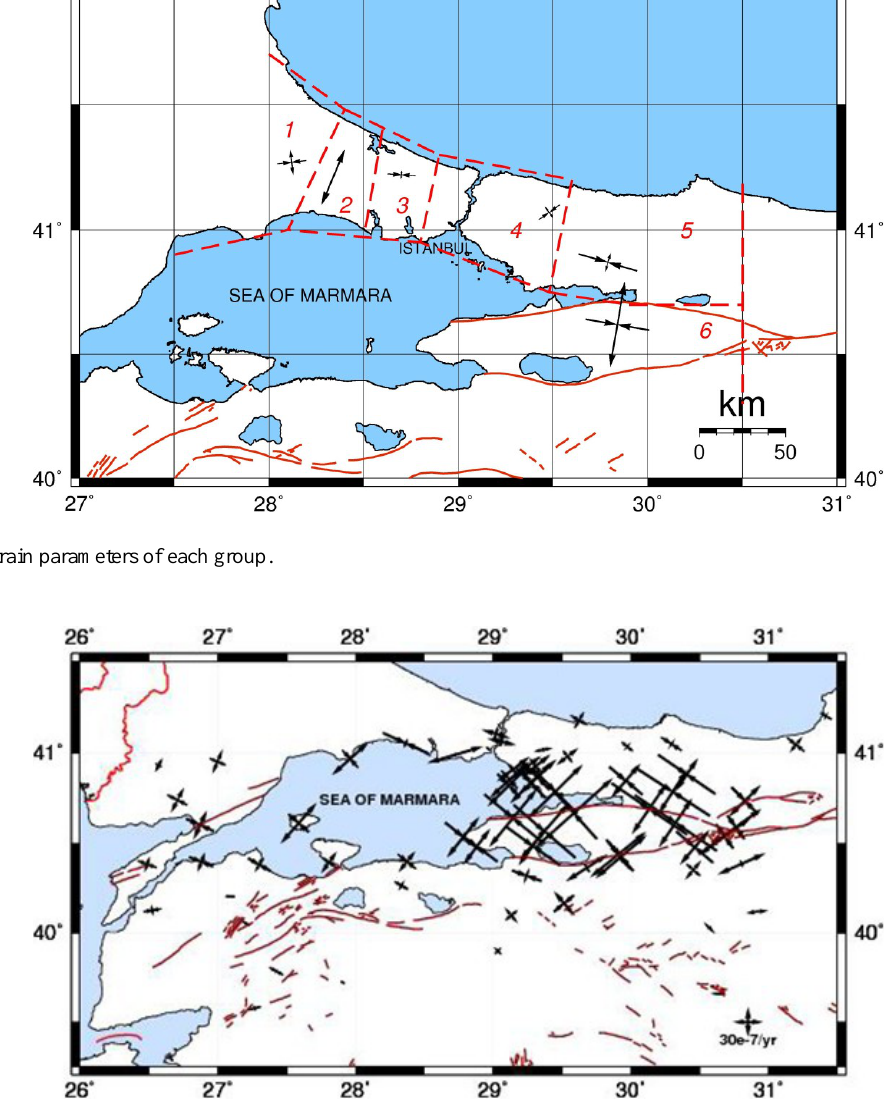
Fig. 5. Principal strain rates from the study of Ozener et al.